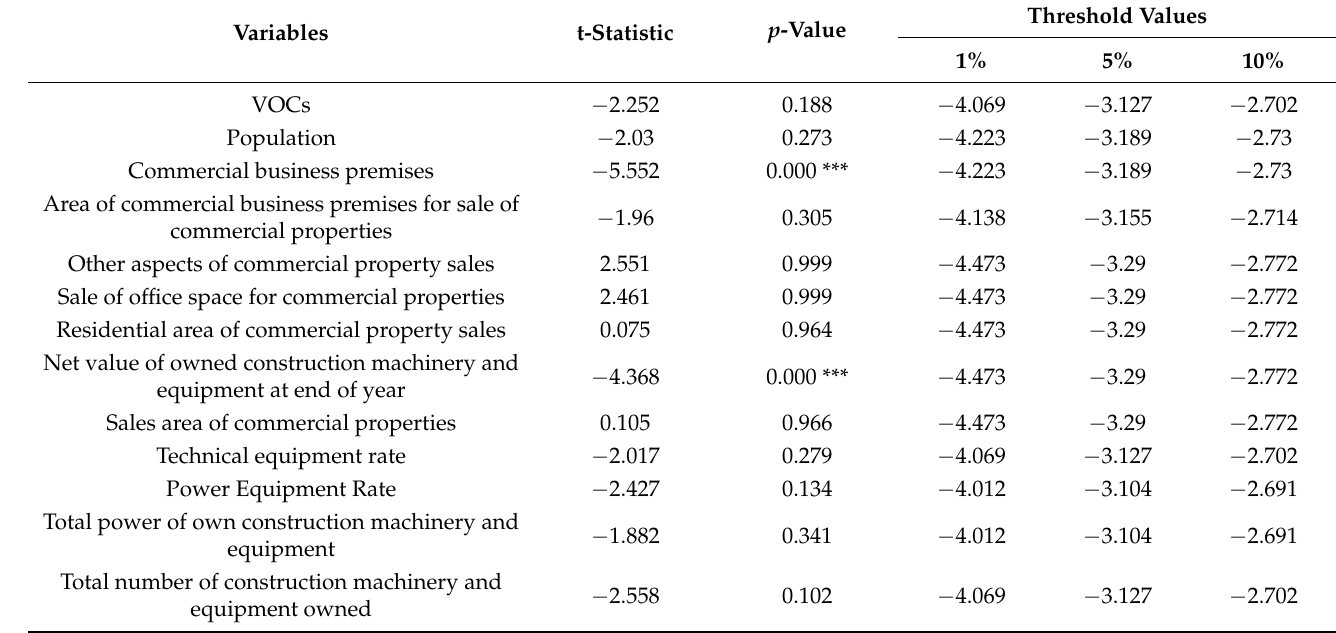
Table 2. ADF test results (***, **, * represent 1%, 5%, 10% level of significance